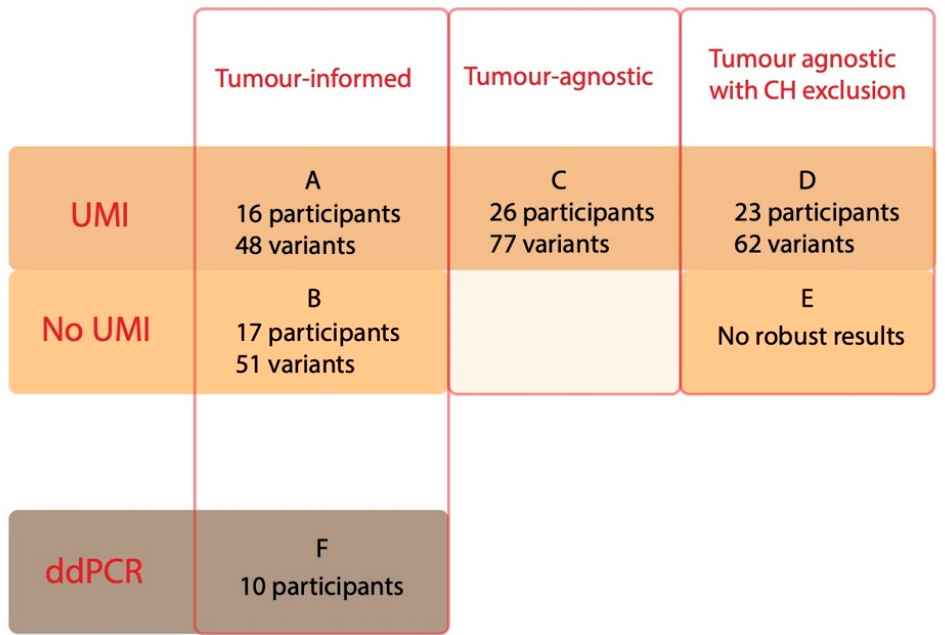
Figure 3. Variants and number of participants with detectable variants for each filtering approach in the diagnostic plasma sample. The number of participants with detectable ctDNA, and the total number of detected variants for each approach is presented in each box, sorted by the bioinformatics approach. In the tumour-informed approach ( A , B ), there were expected ctDNA findings in 31 participants (98 variants) based on findings in the tissue analysis and an available diagnostic plasma sample. In the tumour-agnostic approach ( C ), there were plasma samples available for 44 participants (making them the total number of participants with expected ctDNA findings). In the tumour-agnostic approach with CH exclusion ( D , E ), there were white blood cells and/or two plasma samples available for 43 participants (making them the total number of participants with expected findings). For the ddPCR approach, which was tumour-informed ( F ), 12 participants who were also included in approaches A and B with 19 variants were selected (making them the total number of participants with expected ctDNA findings). ctDNA, cell-free tumour DNA; UMI, unique molecular identifiers; ddPCR, digital droplet PCR; CH, clonal haematopoiesis. The genes TP53 and ARID1A harboured the highest number of potentially cancer- associated variants detected in the tumour-informed approaches (15 and 6 variants, re- spectively). Approach A detected two variants not detected in approach B, and approach B detected five variants not detected by approach A. Fifteen participants had detectable potentially cancer-associated variants in both approaches A and